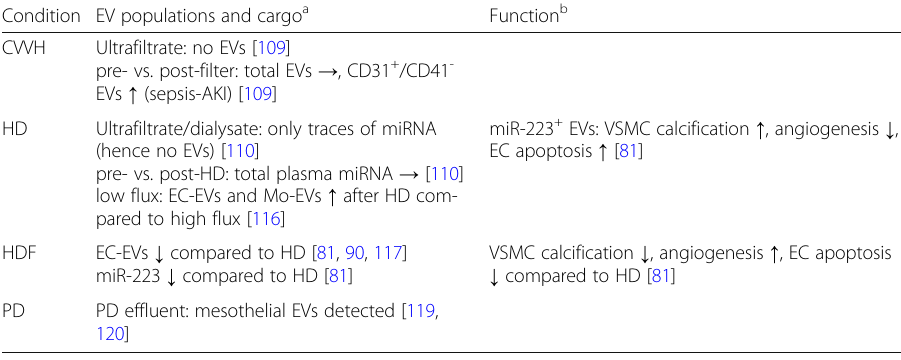
Table 4 Influence of RRT on EV properties in